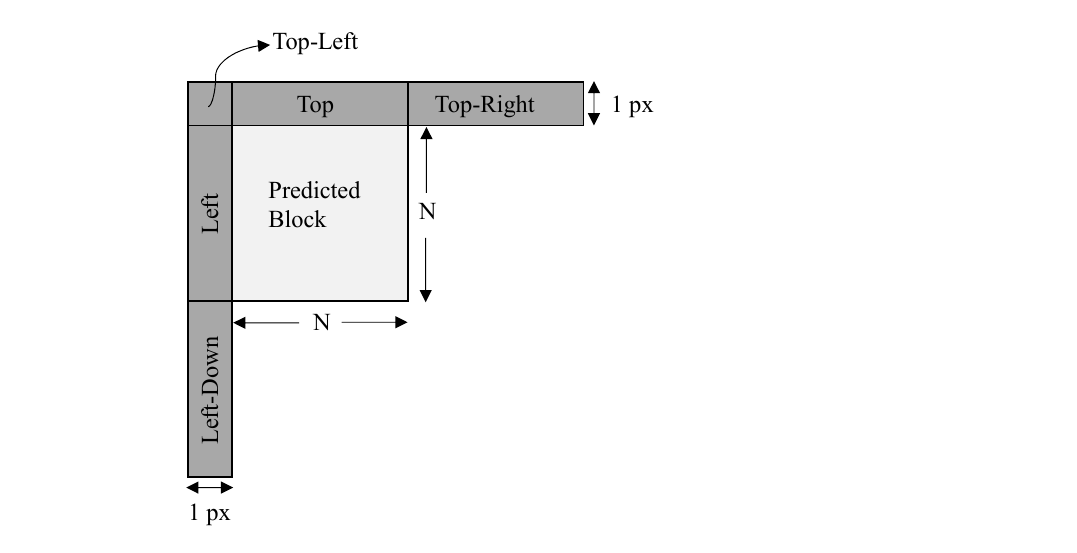
Figure 2. Example of intra prediction model in HEVC. For a predicted block with dimension of N × N, a total of 4N + 1 pixels in the nearest reconstructed row and column are used for prediction.